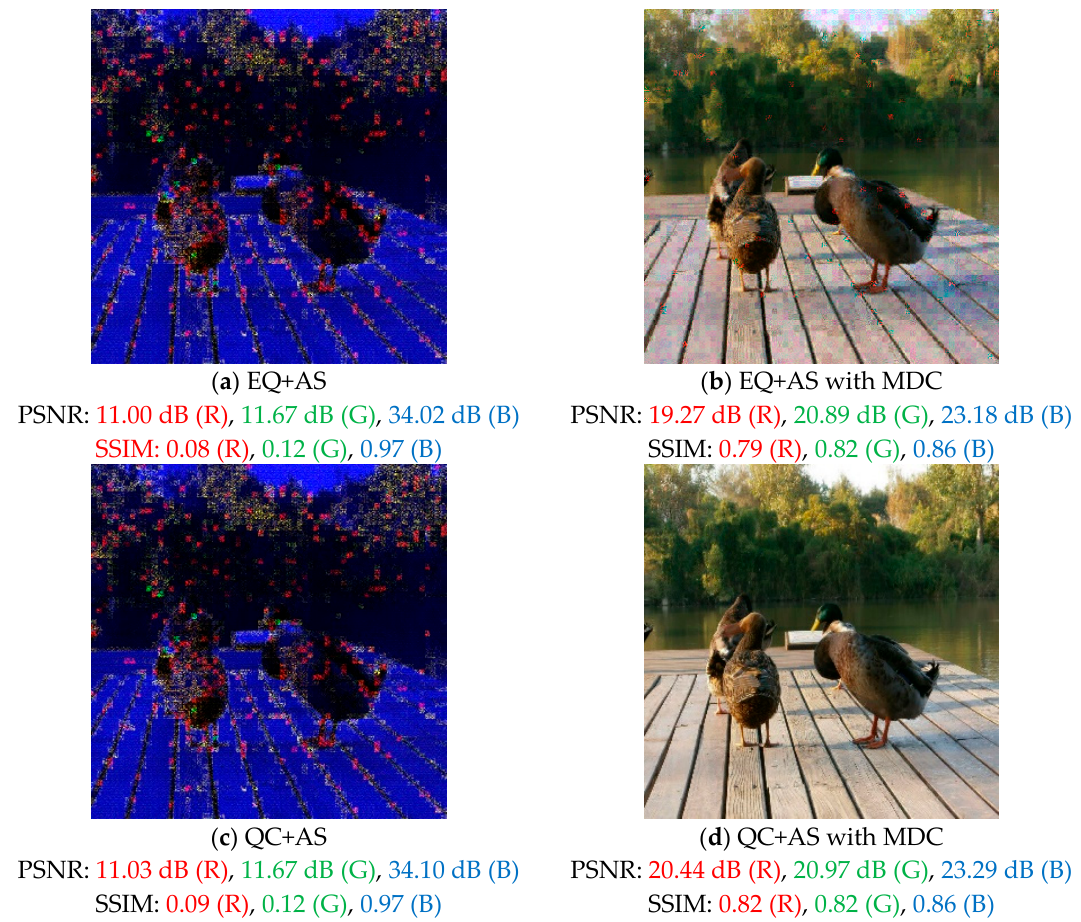
Figure 9. Demonstration of lossy transmission in the red and green planes: ( a ) EQ + AS; ( b ) EQ + AS with MDC; ( c ) QC + AS; and ( d ) QC + AS with MDC.